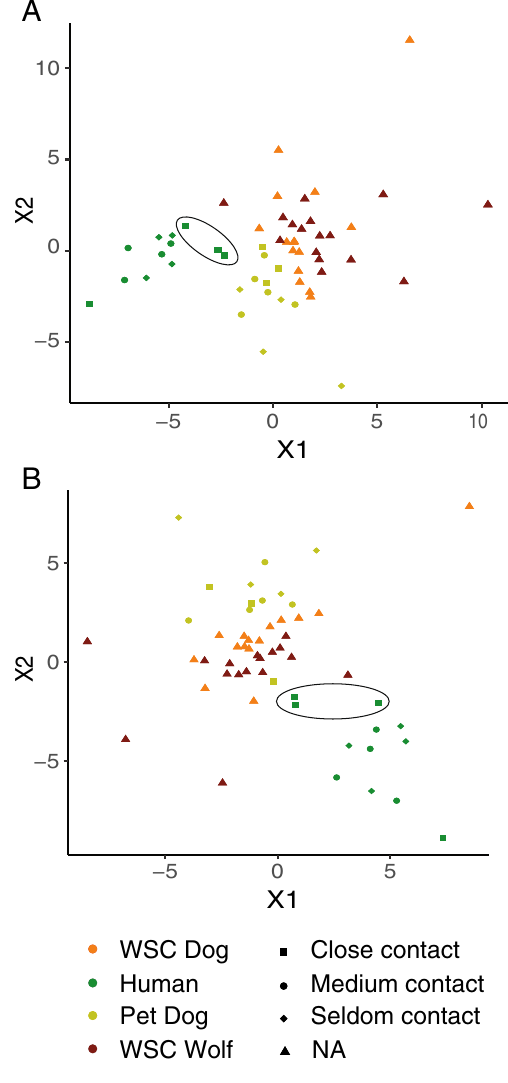
Figure 2. t-distributed stochastic neighbor embedding (tSNE) plots. Humans that have very close and frequent physical interactions with the WSC animals (dog and wolf group) are circled and more similar to the